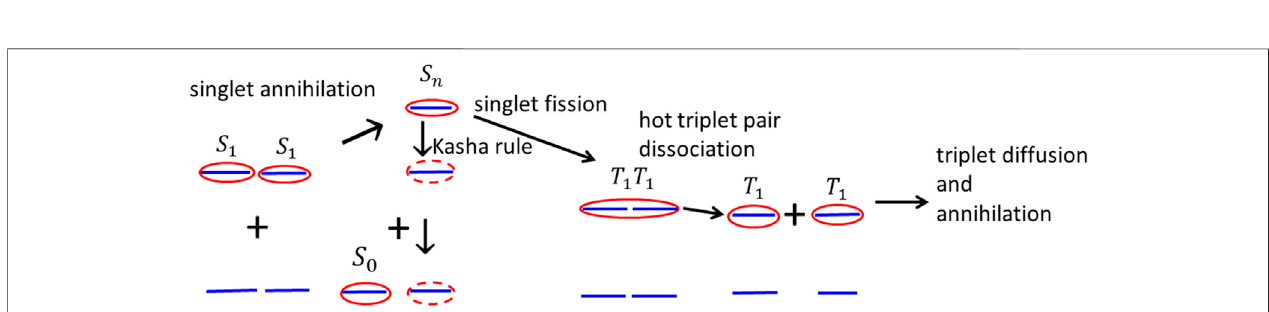
FIGURE9| Schematic fi gureofsubsequentprocessesofmutualsingletexcitonannihilation,formationofintermediatehothighexcitedsingletexciton,formationof the hot intermediate triplet exciton pair, its dissociation to two triplet states, triplet state diffusion, and triplet exciton – exciton annihilation.